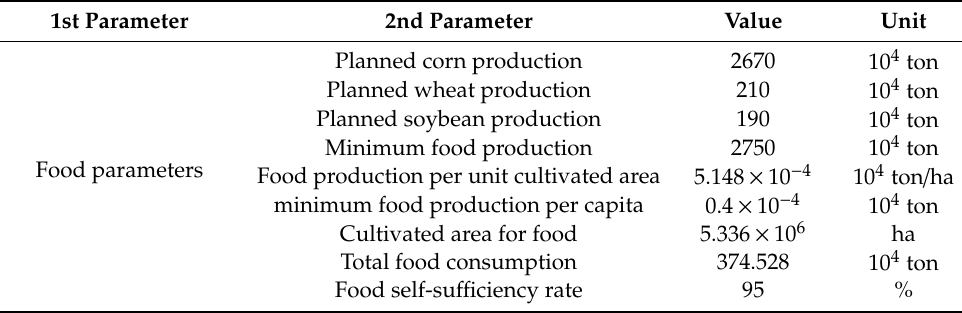
Table 8. Food parameters of a water–energy–food system in Inner Mongolia.